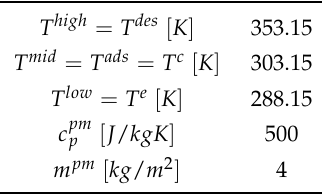
Table 2. Process boundary conditions and geometrical parameters kept constant for all